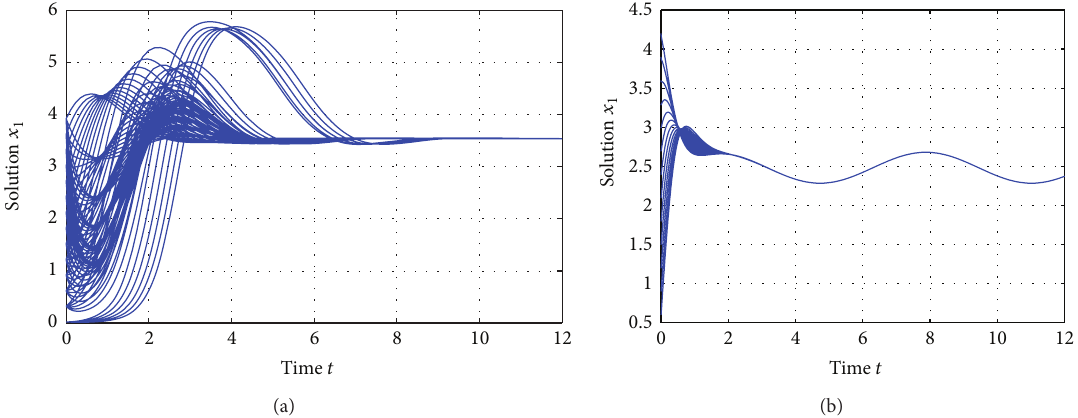
Figure 4: The trajectory of the prey 𝑥 1 of model (30) with (a) 𝑏 1 = 3.0 and 𝜏 = 0 ; (b) 𝑏 1 = 3.0 , 𝜏 ̸=0 , and 𝑥 𝑑 = (2.5+0.2 sin (𝑡),2.0+0.2 cos (𝑡))